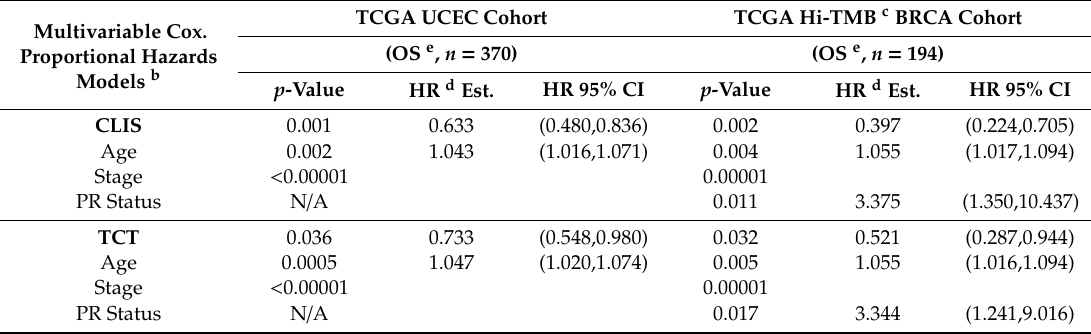
Table 3. Validation of pan cancer-derived immune signatures in TCGA cohorts for uterine corpus endometrial cancer (UCEC a ) and high tumor mutational burden (Hi-TMB) breast cancer (BRCA a